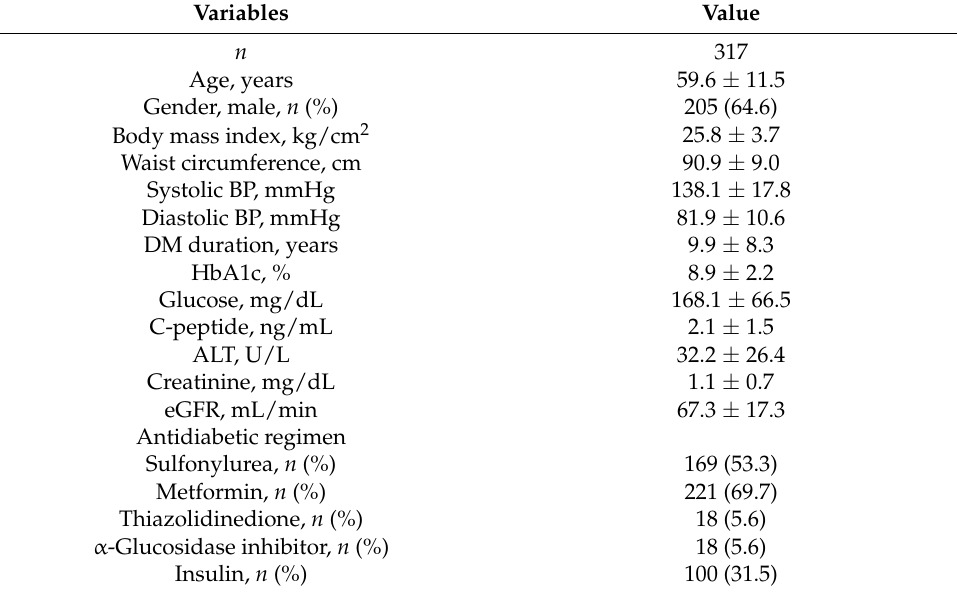
Table 1. Clinical and laboratory characteristics of the study